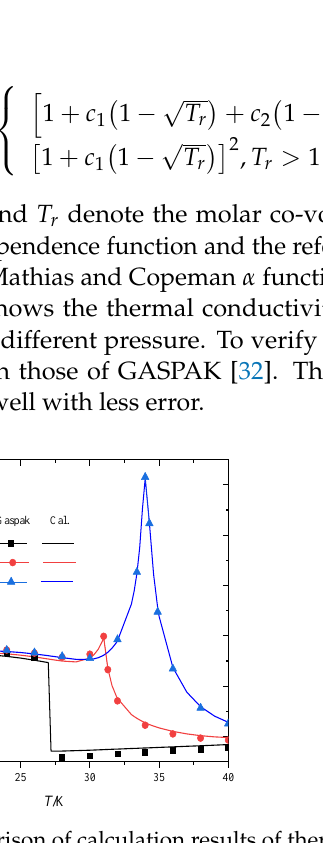
Figure 7. Comparison of calculation results of thermal conductivity with GASPAK.